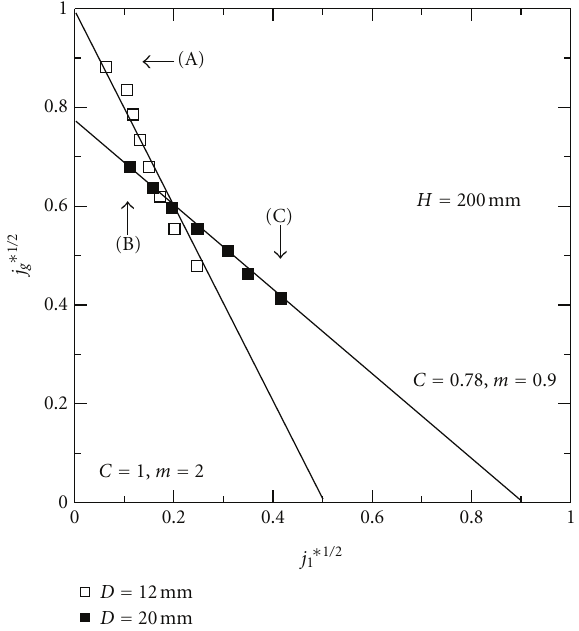
Figure 3: Dimensionless downward liquid flow rate against gas flow rate in CCFL condition for di ff erent tube